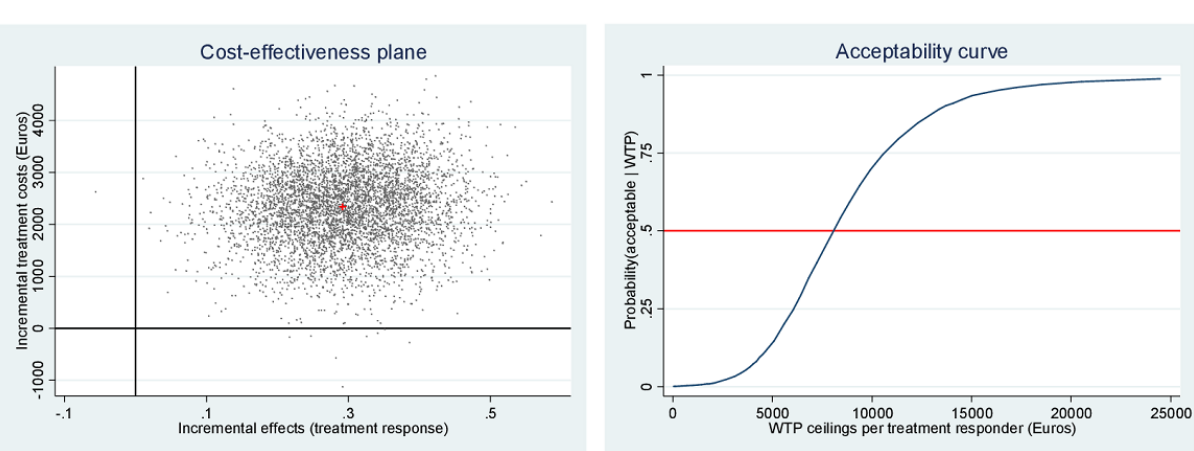
Figure 4. Cost-effectiveness plane and willingness to pay (WTP) acceptability curve for momentary